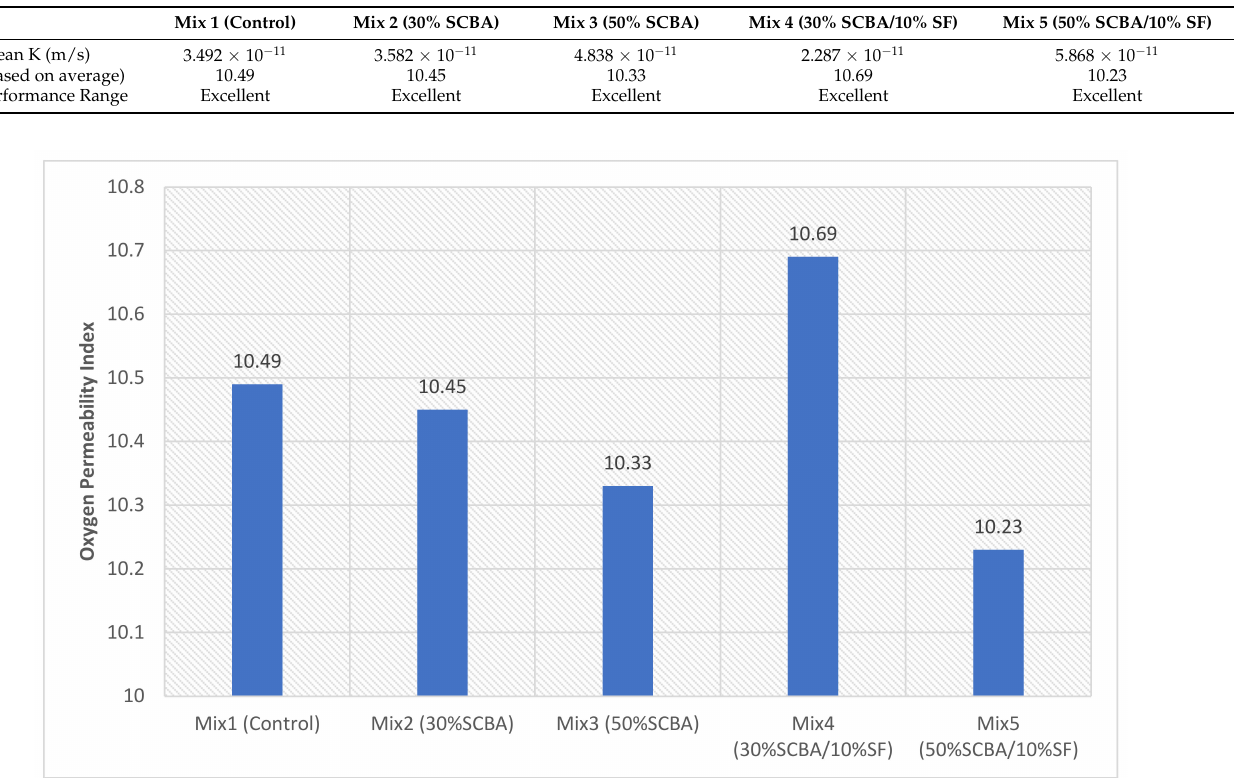
Table 6. Summary of OPI results.